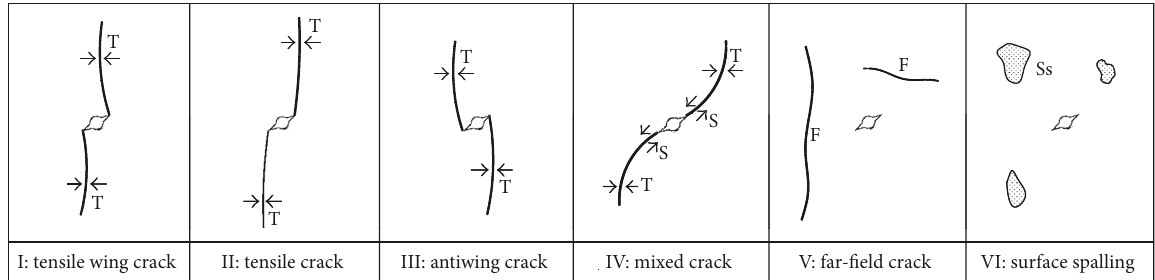
Figure 5: Different crack types in the specimen. T: tensile crack; S: shear crack; F: far-field crack; Ss: surface